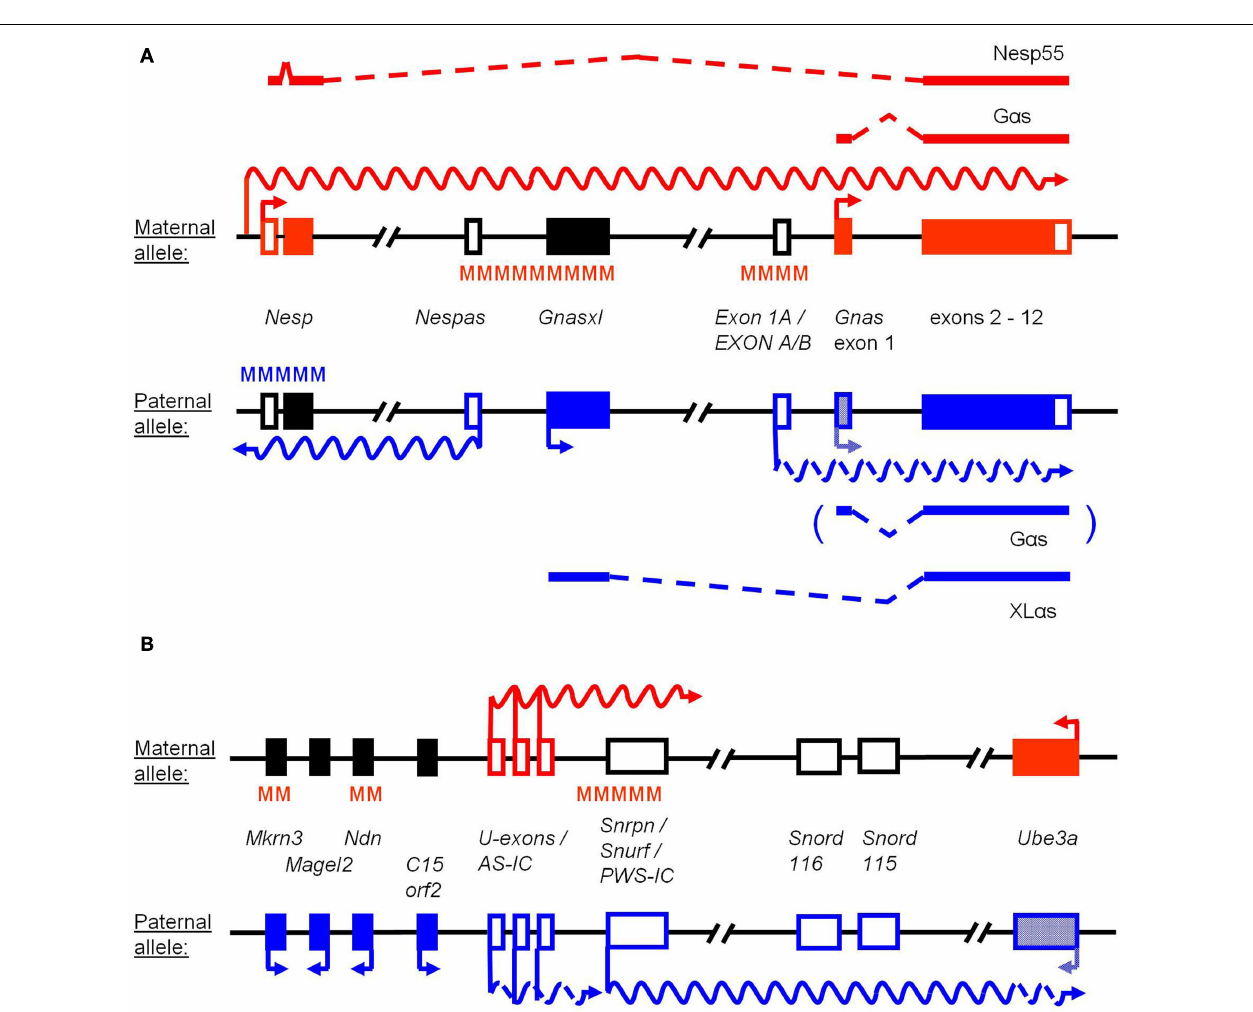
from the unmethylated imprinting control region (ICR) of the locus. (B) The Snrpn-Ube3a imprinting cluster contains several genes (represented by single-exon boxes) that show monoallelic expression in brain. Ube3a is biallelically expressed in most tissues, but silenced on the paternal allele in neurons (hatched box).The Snrpn long ncRNA occurs in multiple, variably processed forms, including brain-specific variants that contain upstream promoters/exons ( U-exons ) and sequences overlapping with Ube3a (interrupted undulating lines). Snord115 and Snord116 represent clusters of C/D box snoRNAs, which are generated from the Snrpn ncRNA.The bipartite ICR of the human locus is indicated as AS-IC and PWS-IC, the latter being conserved in mouse around the main Snrpn start site. C15orf2 is not present in the murine locus. Somatic DMRs at Ndn and Mkrn3 are established during development.Transcription from U-exons occurs in the female germline in growing oocytes (red undulating line) and is involved in the establishment of methylation at the